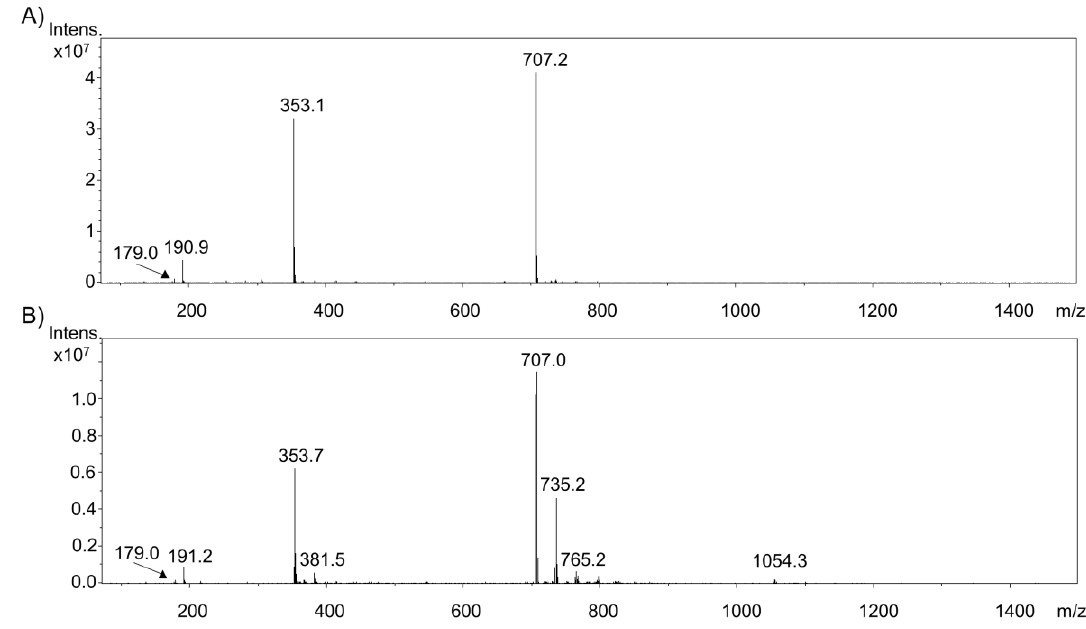
Figure 1. Full scan mass spectra of ( A ) intact chlorogenic acid and ( B ) oxidized chlorogenic acid using a potential of 1.8 V.